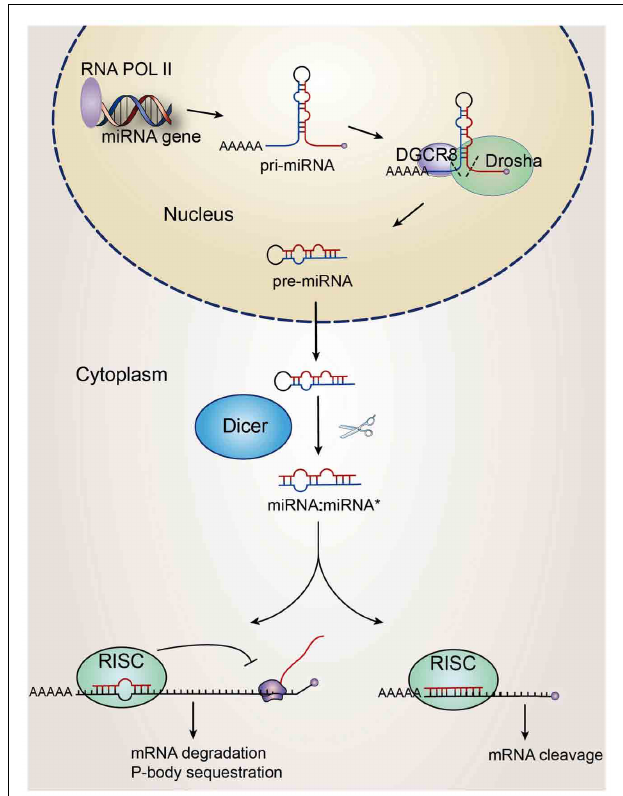
FIGURE 1 | Biosynthesis of miRNAs. The miRNA gene is transcribed by RNA polymerase II as pri-miRNAs which are then processed by Drosha to produce long miRNA precursor (pre-miRNA).The pre-miRNAs are transported to the cytoplasm where they are further cleaved by the endoribonuclease Dicer to mature ∼ 22nt long miRNA–miRNA *duplex. In this process Dicer interacts with theTRBP, PACT, and Argonaute proteins, which form the RNA-induced silencing complex (RISC).Within this complex, one strand of the miRNA duplex is removed and the single stranded miRNA, complementary to the target mRNA, remains in the complex and becomes functional. Seven to eight base pair “seed” sequence in 5 (cid:2) miRNAs is partially complementary to the 3 UTR of mRNA targets, and induces posttranscriptional silencing through mechanisms such as mRNA destabilization and translational